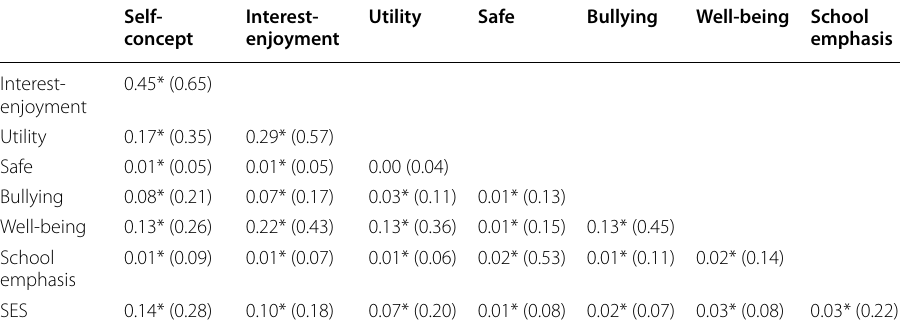
Standardized coefficients are in brackets. *p <